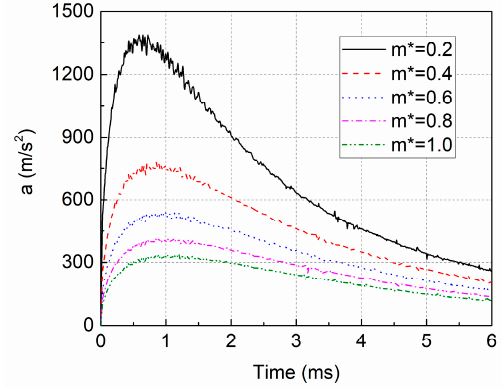
Figure 17. The time history of the acceleration with different masses.